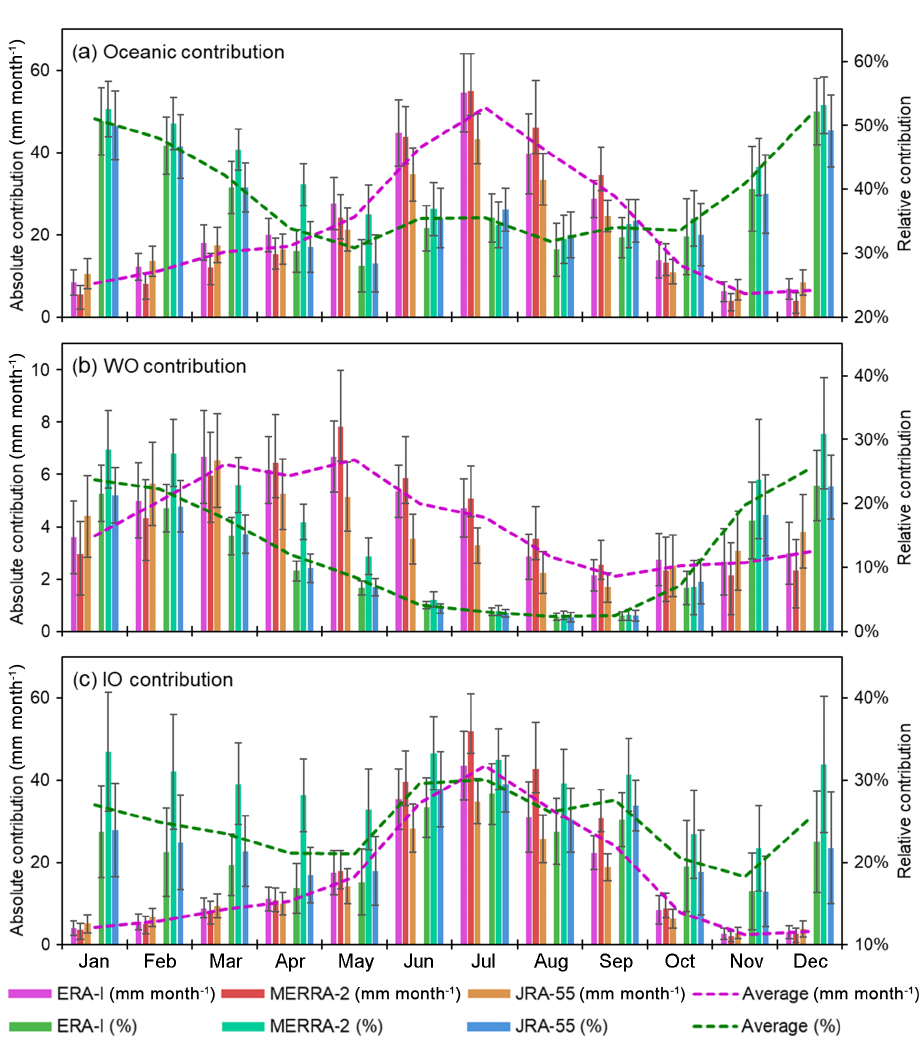
Figure 2. Intra-annual variations of long-term mean absolute and relative oceanic moisture contributions to the TP precipitation. ( a ), ( b ) and ( c ) represent the moisture contributions from the global oceans, the western oceans (WO) and the Indian Ocean (IO), respectively. Pink, red and yellow bars are absolute contributions, and green, cyan and blue bars are relative contributions. All oceanic contributions are simulated using WAM-2layers driven by ERA-Interim (1979–2015), MERRA-2 (1980–2015) and JRA-55 (1979–2015). Dashed pink and green lines are absolute and relative contributions, respectively, averaged across three simulations with different reanalysis datasets. Error bars represent 1 standard deviation of the interannual